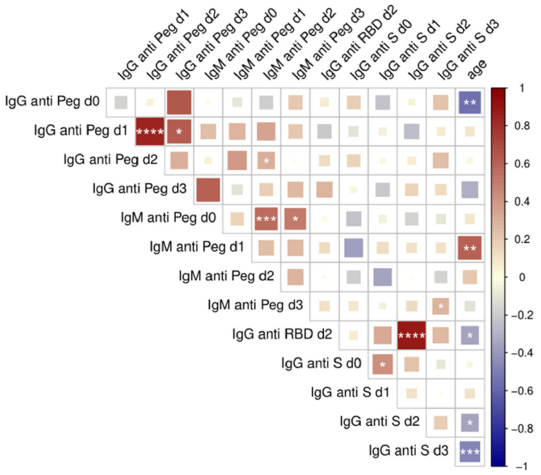
Figure 4. Correlation analysis between anti-PEG, anti-Spike, anti-RBD antibodies and age. Multiple correlations were visualized as matrix with the Spearman’s correlation coefficient values reported. Correlation coefficients were reported with a color scale between red (direct correlation) and blue (inverse correlation) Color intensity and square size are proportional to the absolute value of Spearman correlation coefficients. Statistically significant correlations were labeled as: * p ≤ 0.05; ** p ≤ 0.01; *** p ≤ 0.001; **** p ≤ 0.0001.